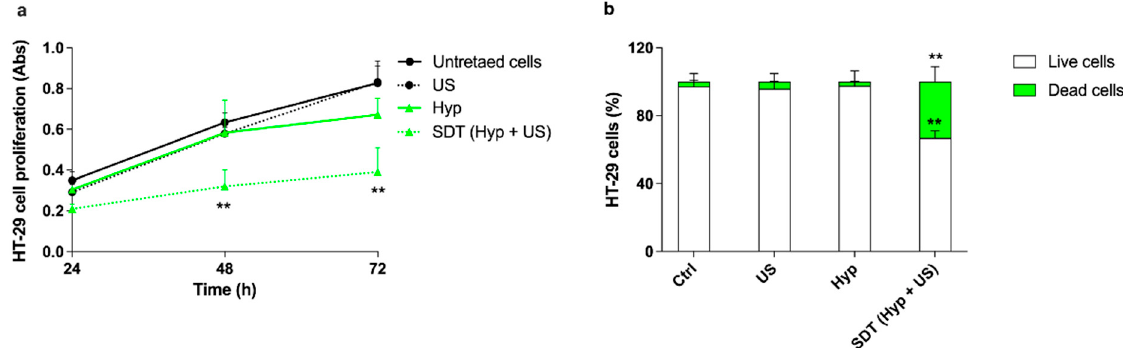
Figure 6 . Effects of hypericin-mediated sonodynamic treatment on HT-29 cell proliferation. HT-29 cells were incubated for 24 h with 0.1 μ M Hyp and then exposed to US (1.5 W/cm 2 at 1.5 MHz, continuous wave mode for 5 min). ( a ) Cell proliferation was evaluated by WST-1 assay 24, 48, and 72 h after treatment. Statistically significant difference versus untreated cells: ** p ≤ 0.01. ( b ) Cell death was evaluated, 48 h after the treatment, using flow cytometry with SYTOX™ green dead cell staining and expressed as cell percentage. Statistically significant difference versus untreated cells (Ctrl): ** p ≤ 0.01 ( n = 3).